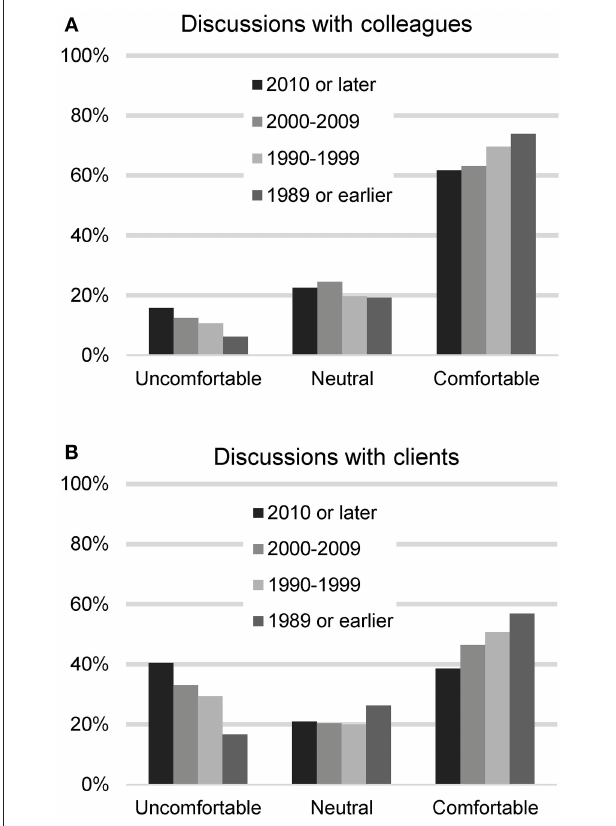
FIGURE 1 | Participants’ reported level of comfort in discussing CBD/hemp with colleagues (A) and with clients (B) , based on year of graduation from veterinary school.